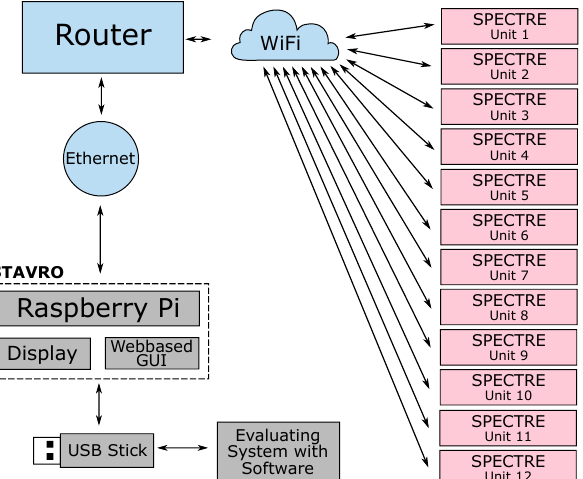
Figure 6. Overall system topology consisting of twelve SPECTRE 3.0 measuring units, one control unit, a router, and a data evaluating system running on a PC.